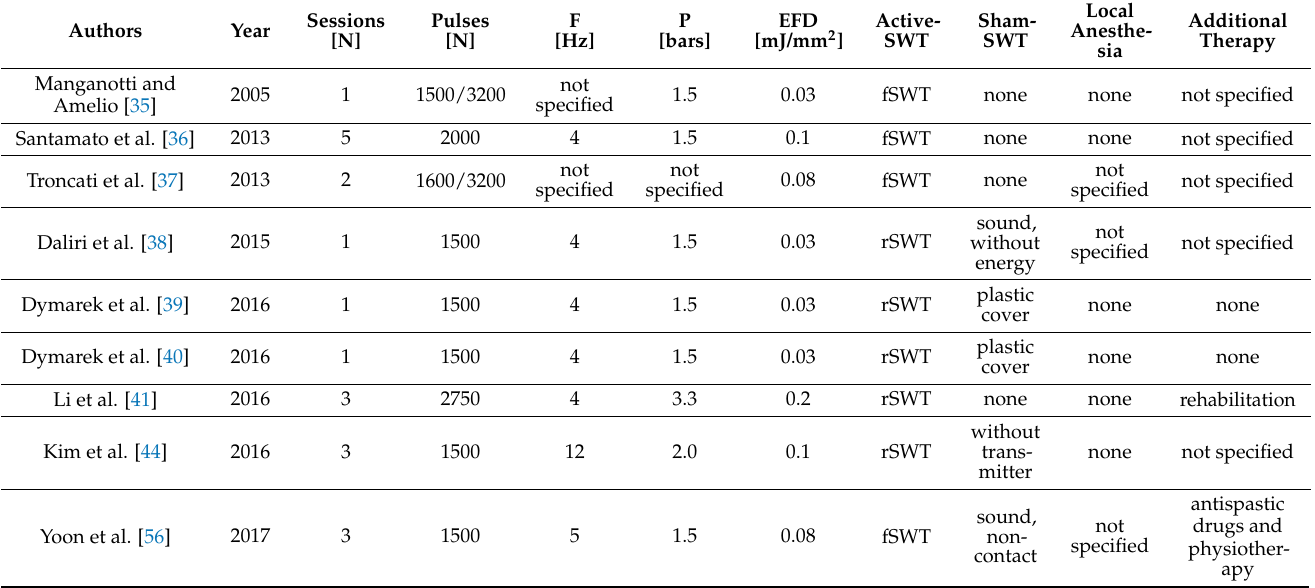
Table 2. Upper limb—characteristics of SWT procedure and